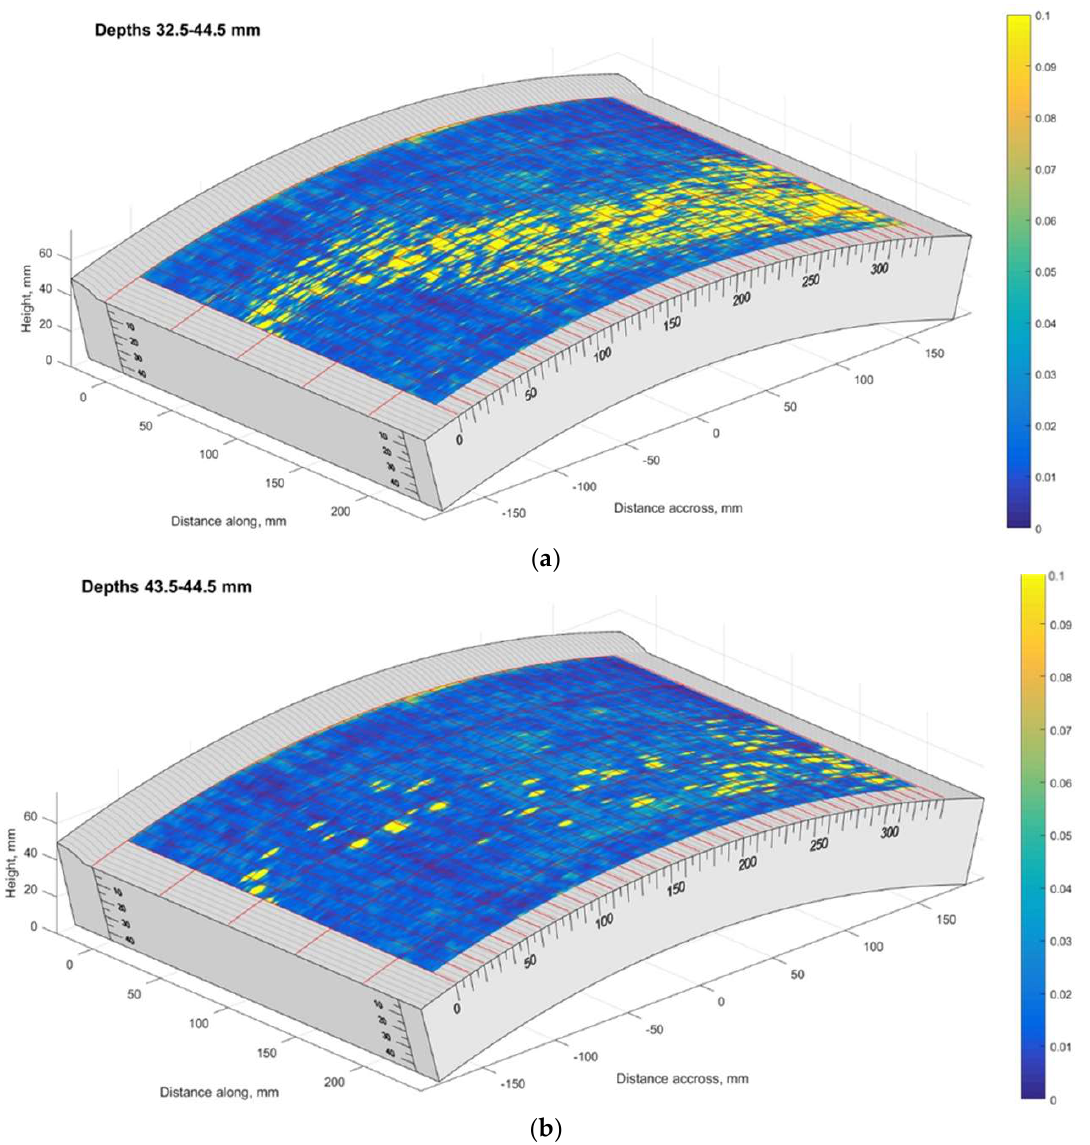
Figure 18. The TFM scan of the Sample No. 5: ( a ) depth range of 32.5–44.5 mm, ( b ) depth range of 43.5–44.5 mm. Vertical colour bar represents the peak-to-peak amplitude in arbitrary units.